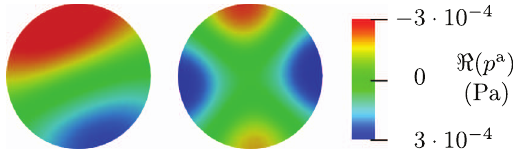
Figure 14. Real part of the Fourier transform of the acoustic pressure obtained by the PCWE for C1 at f 10 = 4044.7 Hz (left) and f 20 = 6709.6 Hz (right).